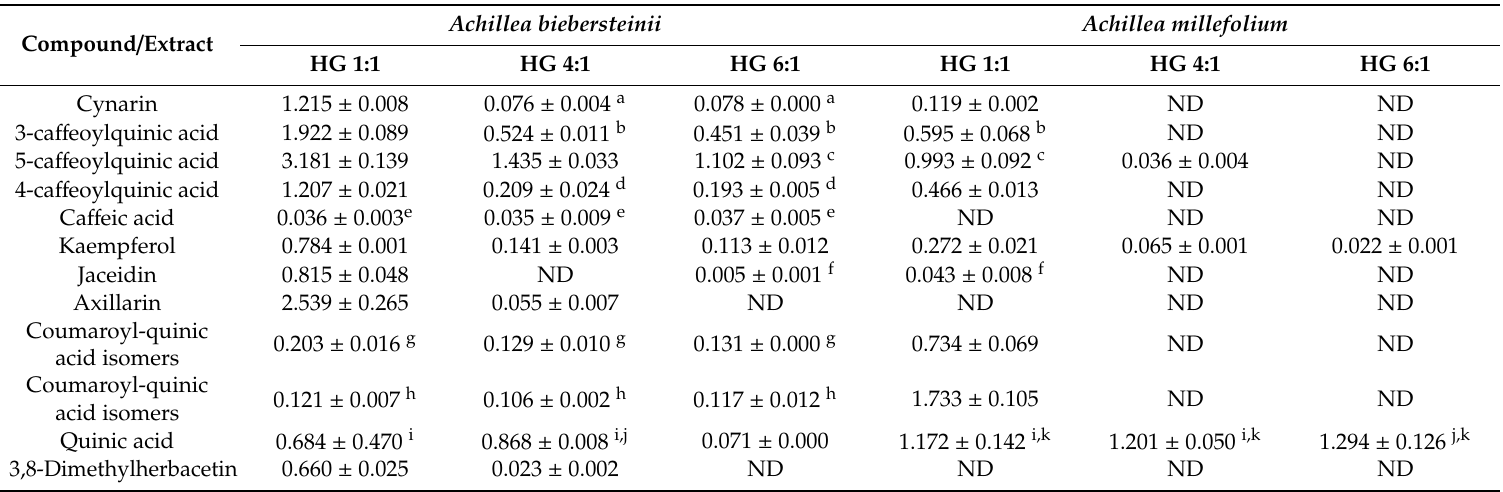
Table 3. Quantitative analysis of the selected identified compounds in A. millefolium and A. biebersteinii hydroglycolic extracts *; each value represents mean content of the compound in mg per 100 g of dried powder ± SD ( n = 3 ); ND—not detected